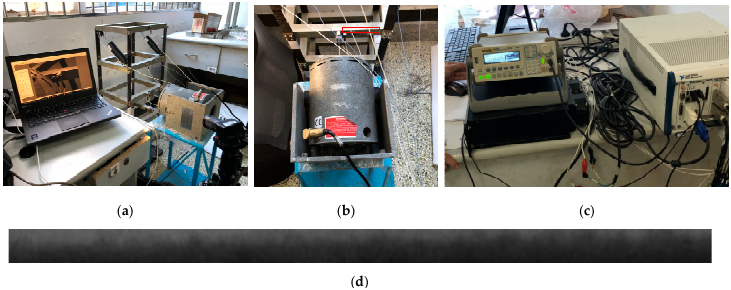
Figure 4. Experimental setup for verification test: ( a ) Camera, laptop, and steel structure; ( b ) MB Dynamics MODAL 50 exciter (ROI highlighted in red rectangle); ( c ) RIGOL DG1022 arbitrary waveform generator; ( d ) ROI for vibration frequency measurement.